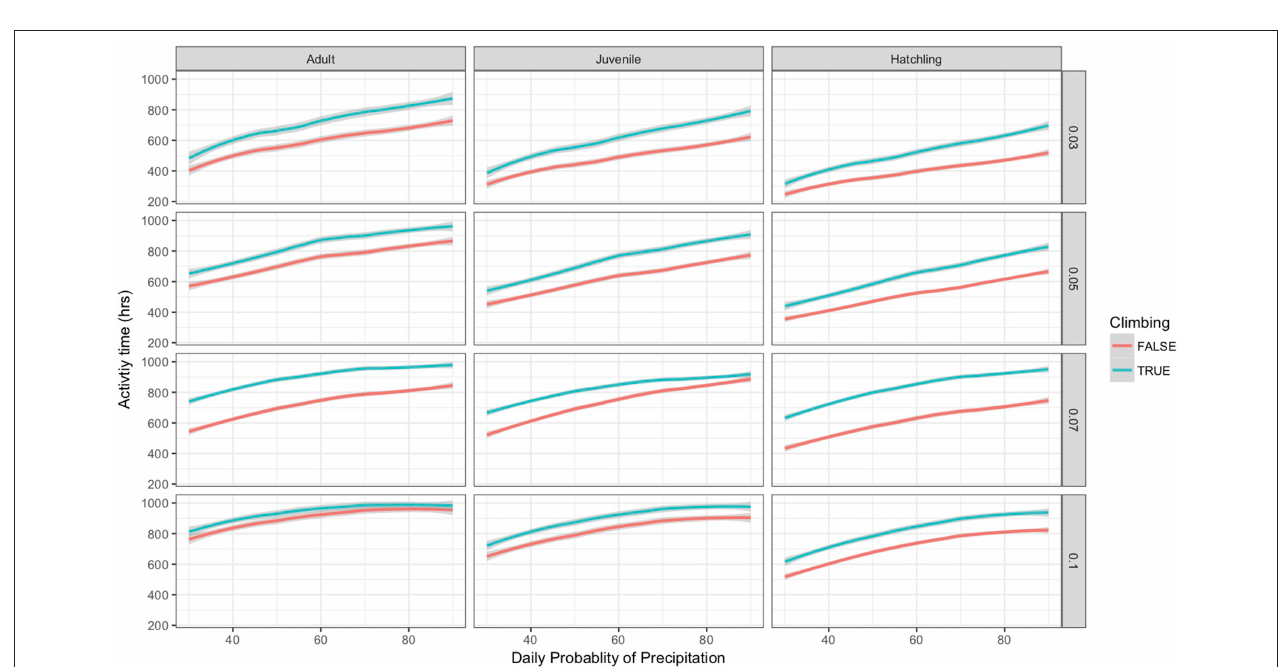
FIGURE 3 | Estimated mean total seasonal activity time, restricted to nights when climbing occurred, for climbing and non-climbing adult, juvenile, and hatchling salamanders as a function of the probability of precipitation and water loss threshold in the model simulation. The lines were smoothed using a logarithmic linear model fit to the data, gray bands surrounding each line indicate a 95% confidence interval. Each water-loss threshold is shown individually as indicated by the far right axis.